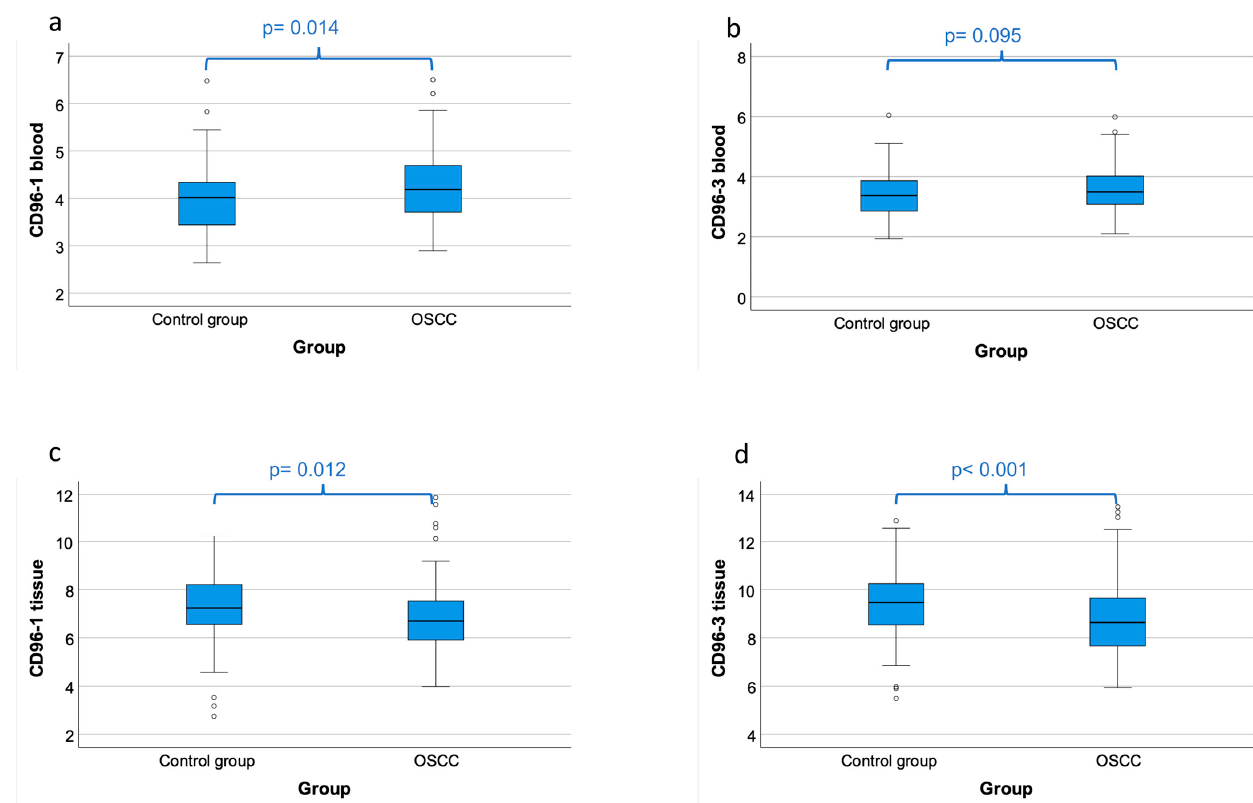
Figure 2. CD96 mRNA expression in peripheral blood and tumor tissue of OSCC patients and controls. Box plots showing the median CD96 mRNA expression rates in peripheral whole blood samples of OSCC patients (OSCC) and healthy volunteers (control group) ( a , b ) as well as tumor tissue of OSCC patients and healthy oral mucosa of volunteers ( c , d ). The median Δ CT values of CD96 transcript variant 1 ( a , c ) and transcript variant 3 ( b , d ) expression levels derived from RT-qPCR are given. Lower Δ CT values indicate higher CD96 mRNA expression. The median, the interquartile range, and the standard deviation are provided. Statistical analyses were carried out using the Mann–Whitney U test. ° outliners.